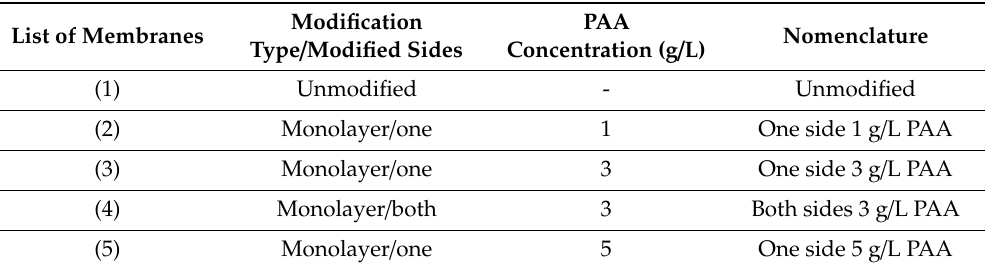
Table 1. Anion-exchange membranes (AEMs) under study: classification and